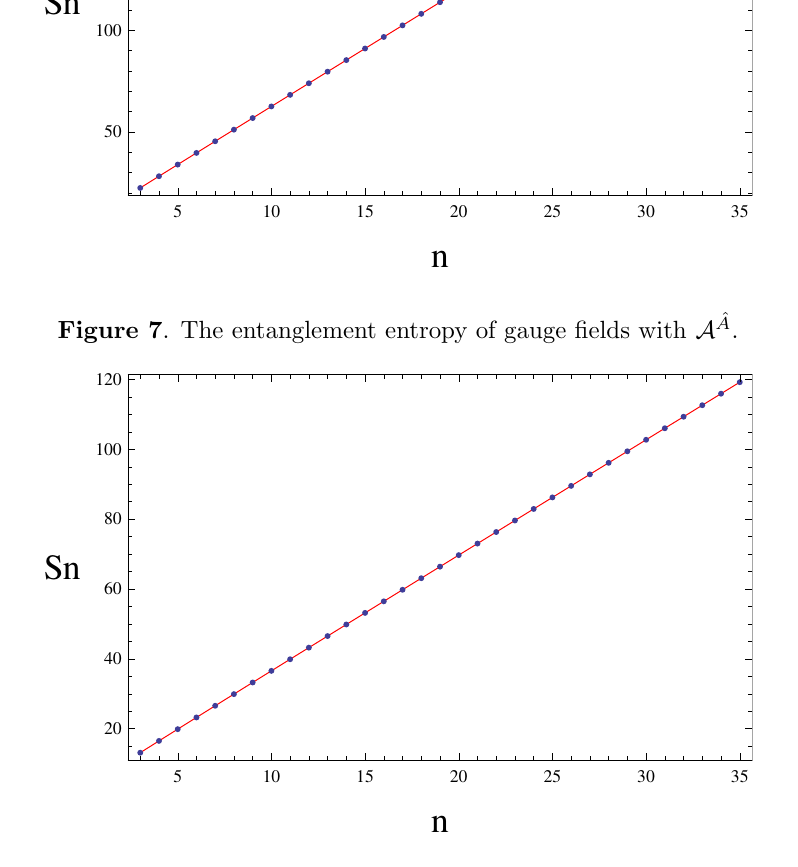
Figure 8 . The entanglement entropy of gauge (cid:12)elds with A (cid:25) . region becomes large. To calculate the entanglement entropy of gauge (cid:12)elds with non- trivial centers, we have to remove one physical degree of freedom after gauge (cid:12)xing. The results are as